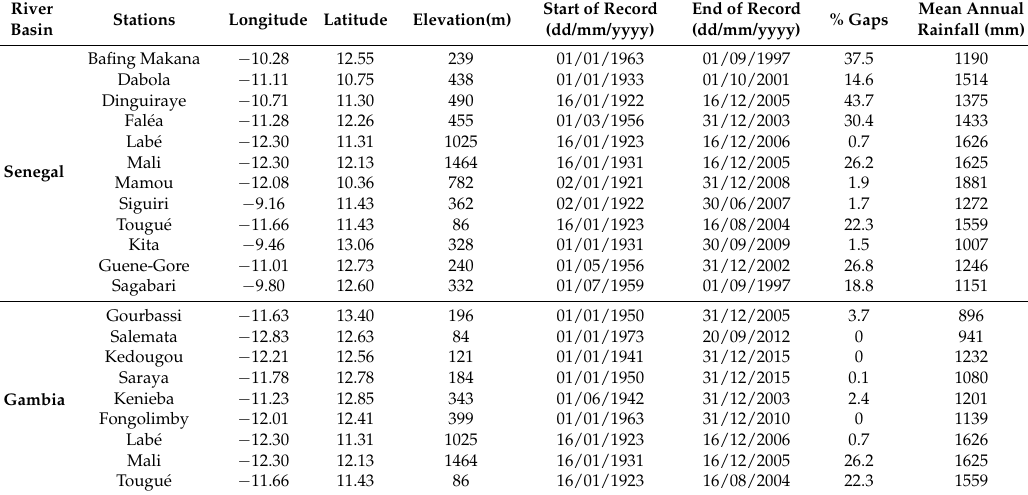
Table 1. Rainfall stations for the two river basins: Mean annual rainfalls from observed series without gaps; %gaps = percentage of days without measurement.